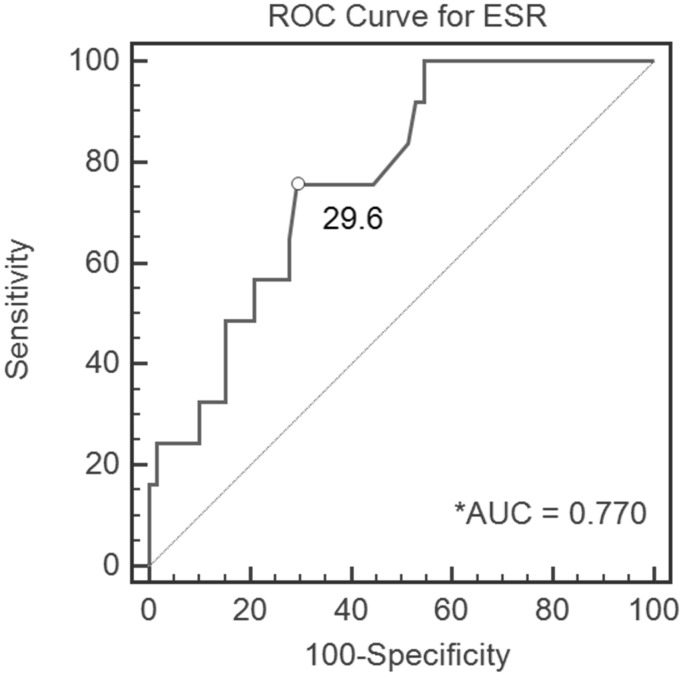
Receiver operating characteristic (ROC) curve, demonstrating the erythrocyte sedimentation rate (ESR) cutoff value of 28 mm/h for all patients in the cohort.*AUC, area under the curve.